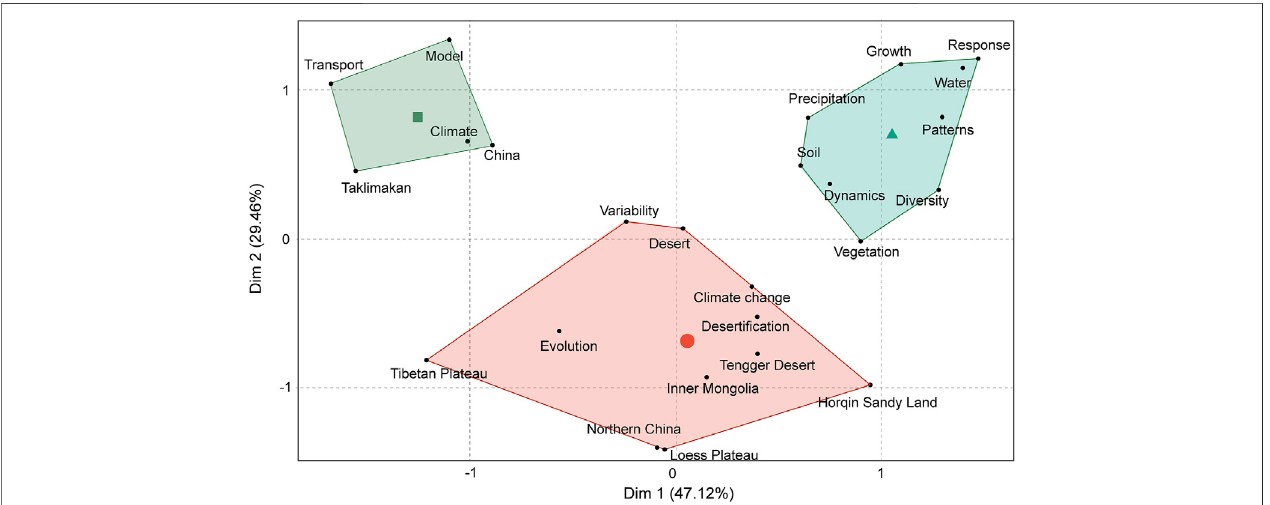
FIGURE 6 | The concept map for the research on deserts in China based on correspondence analysis. Each color represents a cluster of words (i.e., a topic).